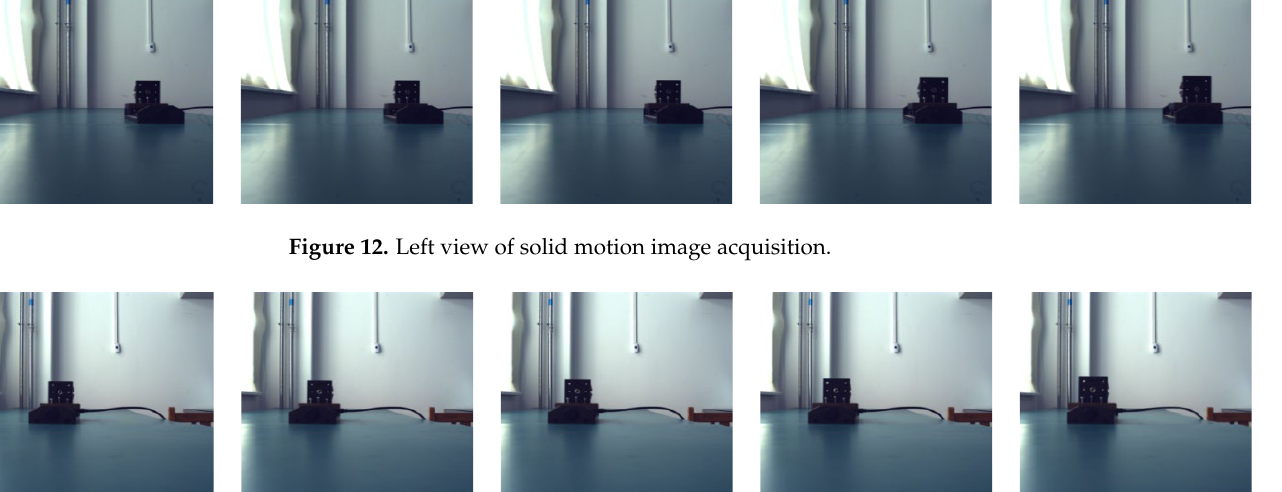
Figure 13. Right view of solid motion image acquisition.